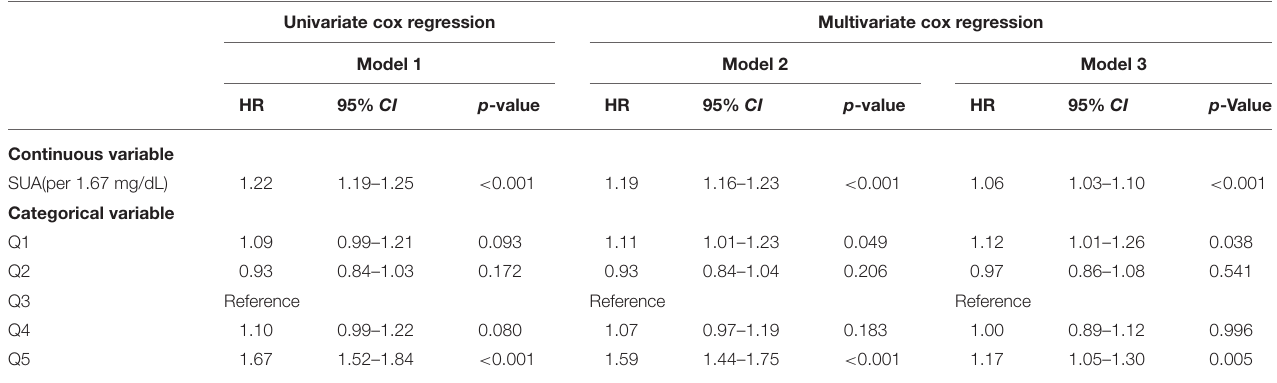
TABLE 2 | Cox regression models for SUA and all-cause